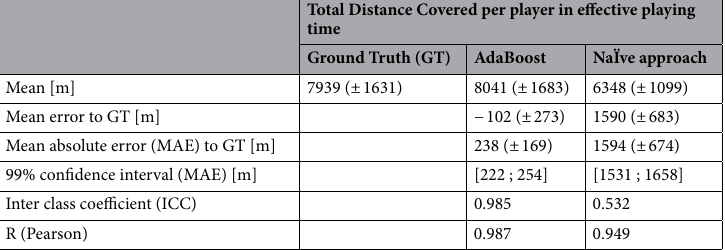
Table 3. Total distance covered per player in the effective playing time calculated with in-game status data of ground truth, AdaBoost prediction and a naïve approach for 751 players that played only the full match and without goalkeepers. Differences between ground truth to AdaBoost prediction and the naïve